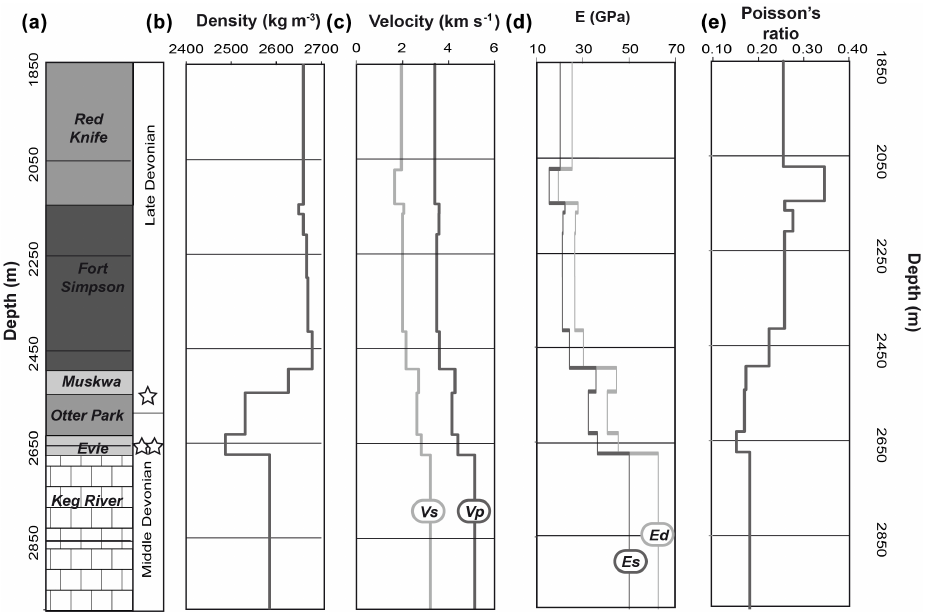
Figure 4. Petrophysical and mechanical properties of the study case. (a) Lithological section: Fort Simpson, Muskwa, Otter Park, and Evie members are clay-rich rocks represented in various shades of gray. The Keg River Formation is carbonate. The Muskwa, Otter Park, and Evie members together form the Horn River Formation. The white stars represent the locations of stress measurements. (b, c) Depth dependence of the density and the P- and S-wave velocities are derived from the well data. (d, e) Variation of the Young’s modulus and Poisson’s ratio with depth are calculated from the density and velocities, respectively. In (d) the dynamic and static Young’s moduli are indicated.